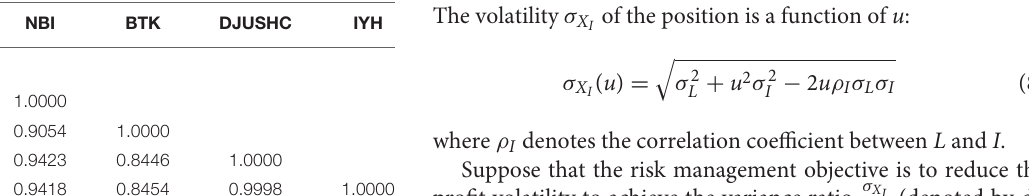
TABLE 4 | Correlation matrix (The USA).